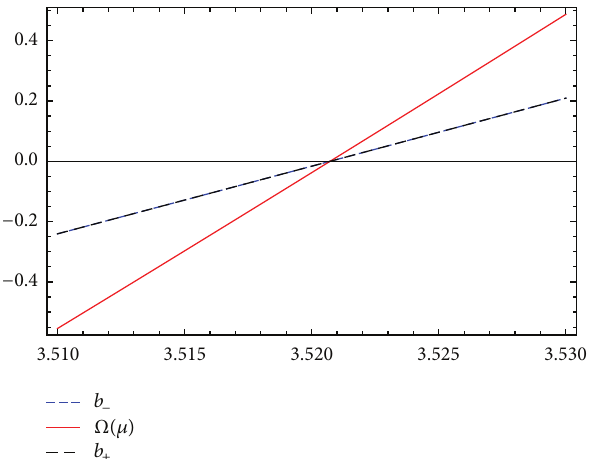
Figure 4: The enclosure interval dominating 𝜇 2 for 𝑚 = 10 , 𝑁 = 15 , 𝜃 = 1/5 , and 𝜀 = 10 −10 .